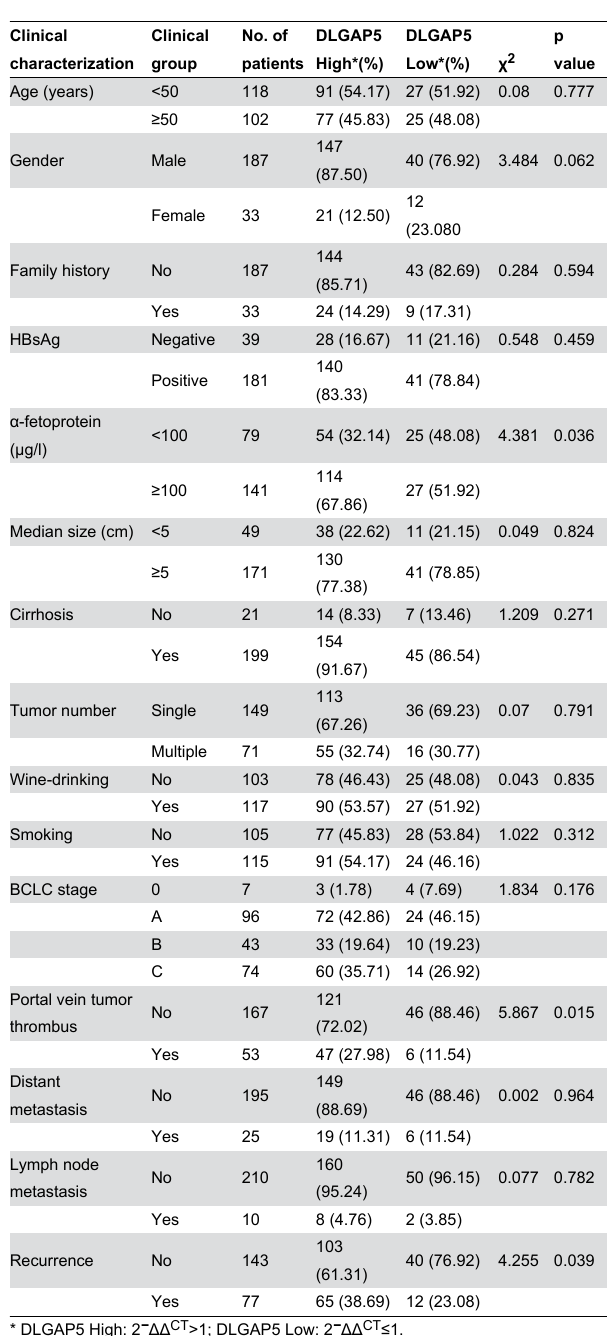
Table 1. Summary of Analyses of DLGAP5 gene in 220 HCC